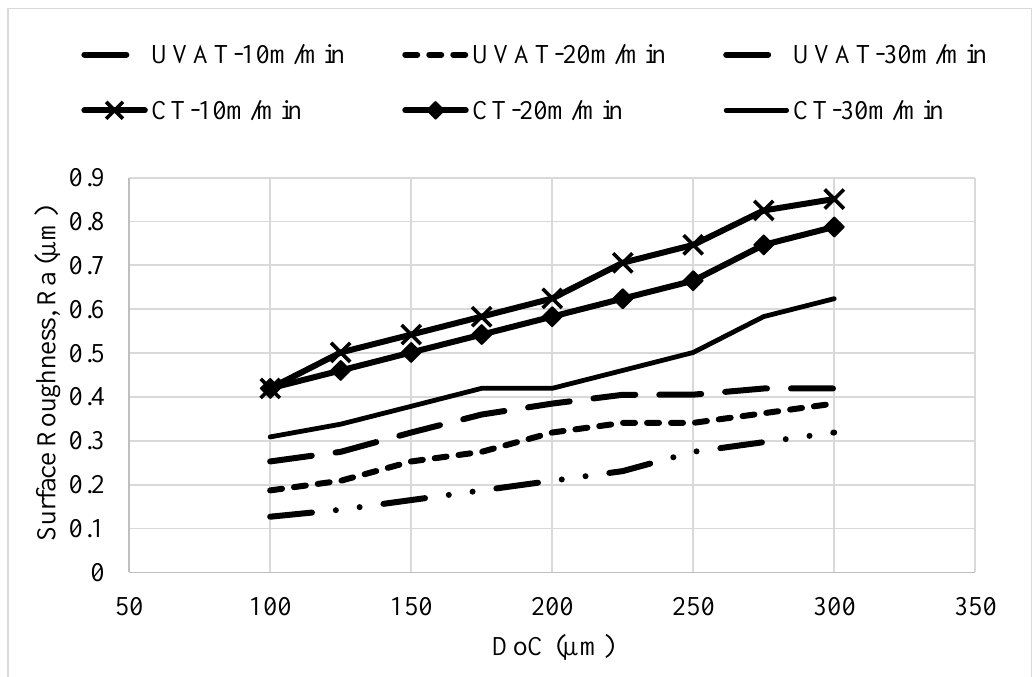
Figure 8. The predicted Ra in UVAT and CT.